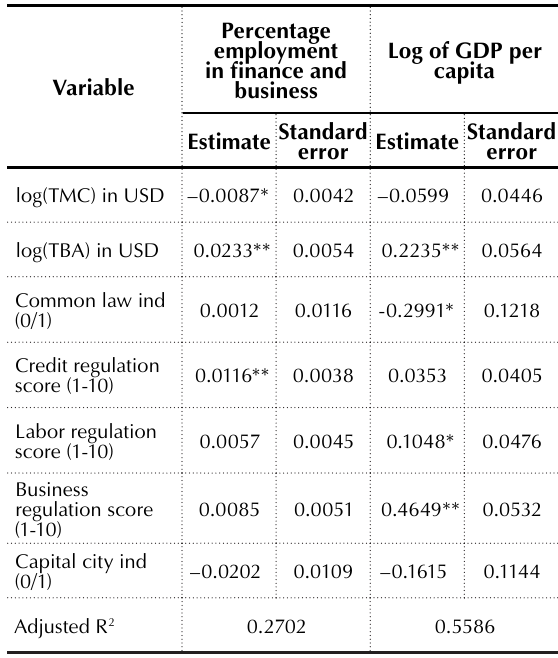
Table 3. The effect of Total Market Capitalization, Total Bank Assets, and other selected explanatory factors on GDP per capita and percentage of jobs in finance and